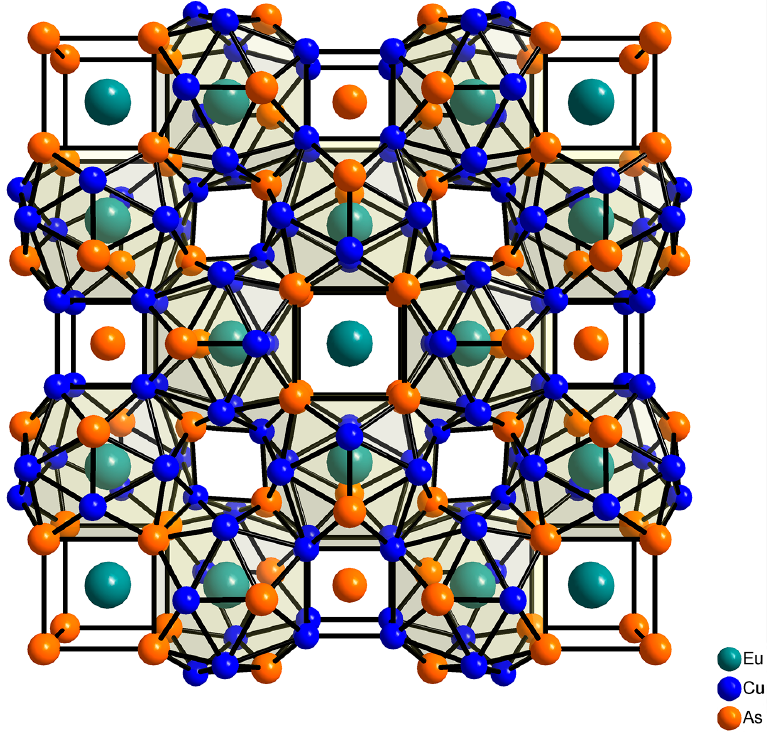
Figure 1. Projection of the Eu 7 Cu 44 As 23 crystal structure onto the (001) plane.